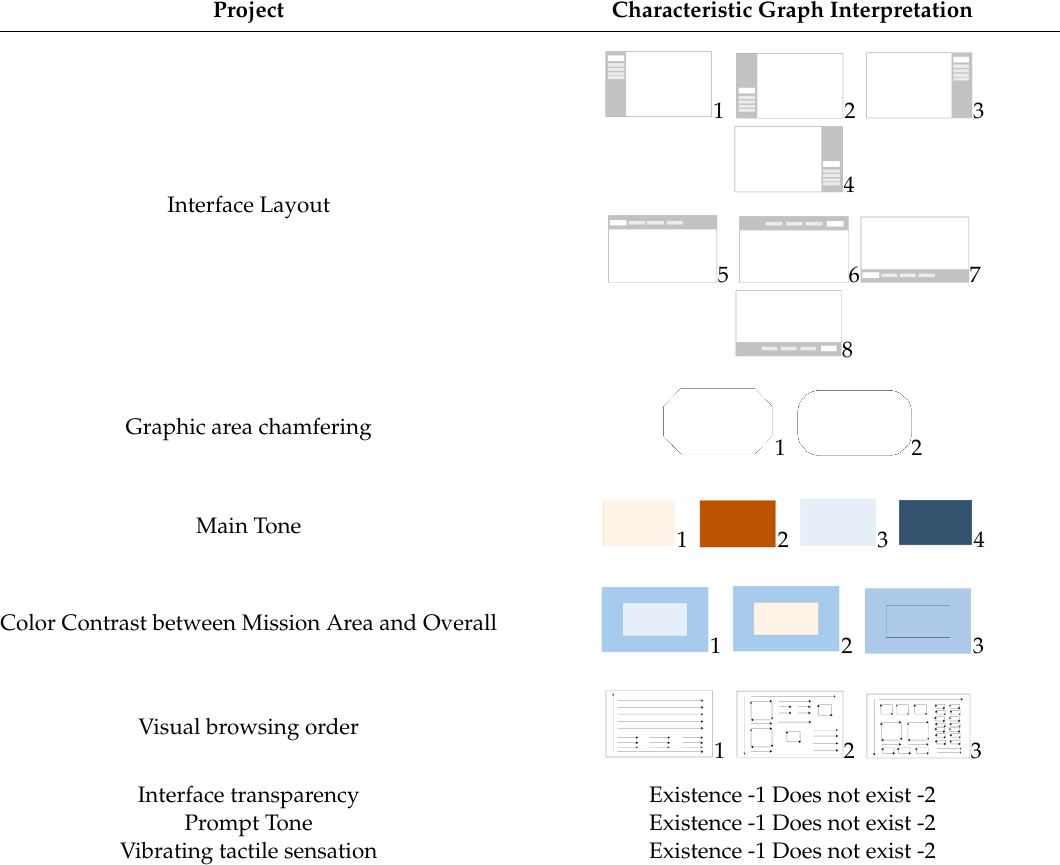
Table 13. Virtual reality (VR) information interface scenario design element table.